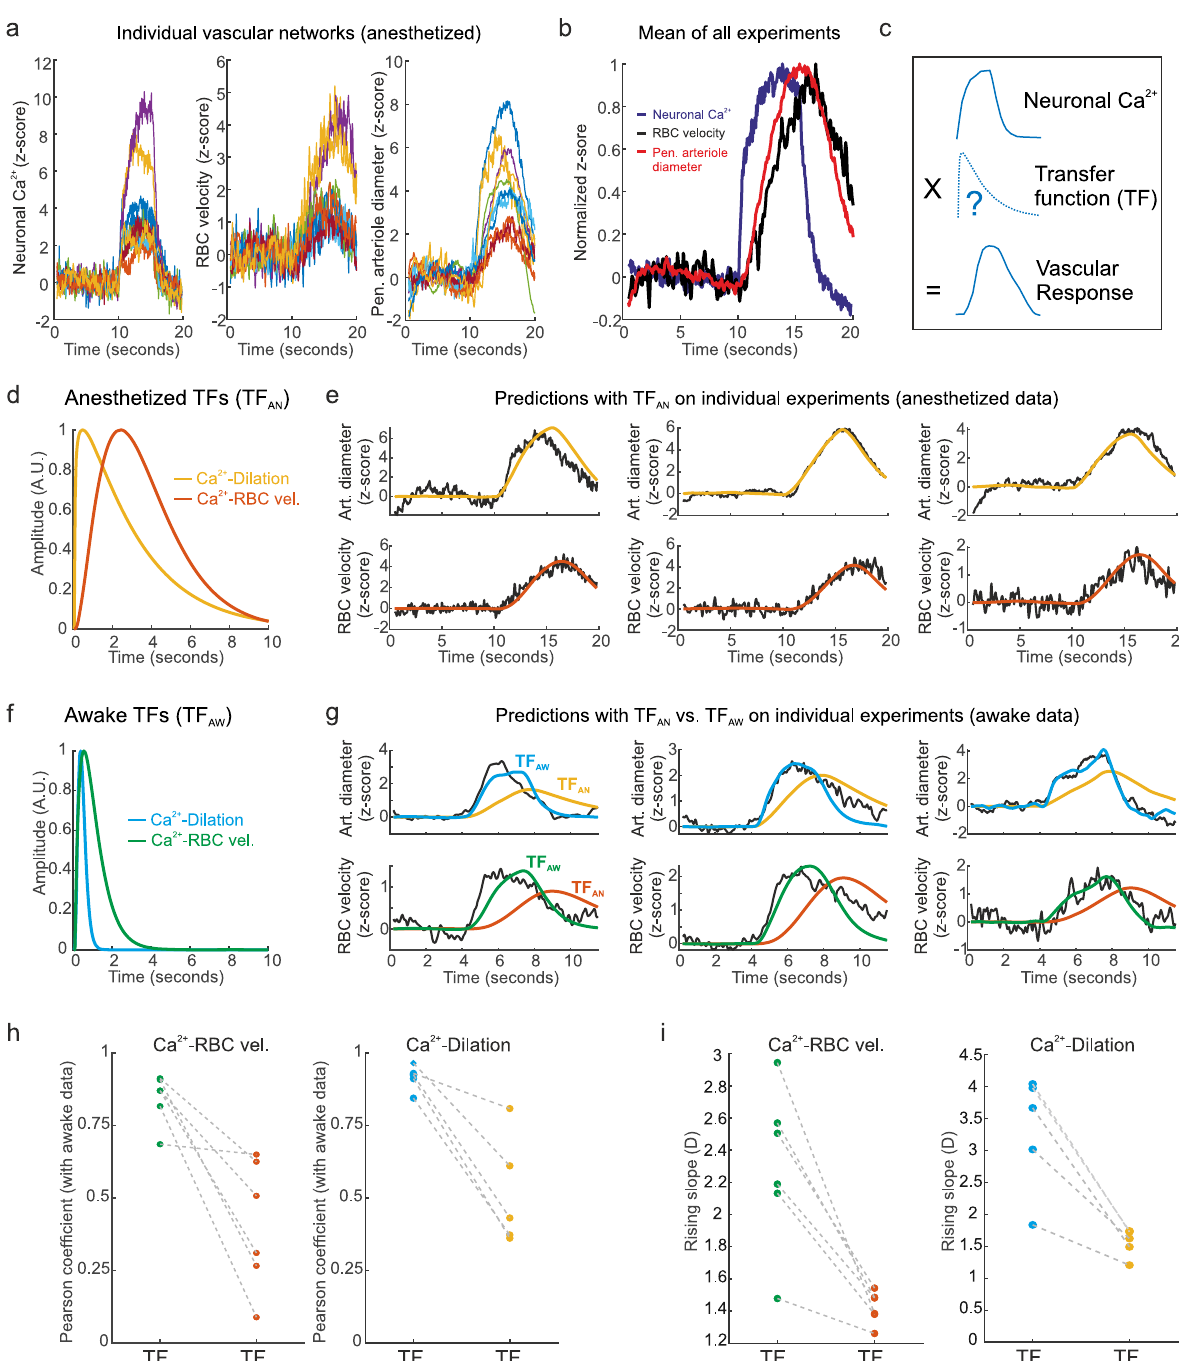
Fig. 4 Analysis of differential NVC dynamics in awake vs. anesthetized mice using TFs. a Overlaid dynamics of Neuronal Ca 2 + (GCaMP6 signal), RBC velocity ( ≥ 4th order capillaries), and penetrating arteriole diameter from all anesthetized experiments (10 vascular networks, 6 mice). b Mean traces of normalized data shown in a . c Transfer functions (TFs) are convolved with the average neuronal Ca 2 + signal and optimized to predict the vascular response (RBC velocity or arteriole diameter). d TFs optimized to predict arteriole dilation (yellow) or RBC velocity (orange) dynamics computed with the mean anesthetized data. e TF predictions for arteriole diameter (top) and RBC velocity (bottom) from the experimental data from 3 different anesthetized experiments (TF AN ), top and bottom are paired experiments. f TFs optimized to predict arteriole dilation (blue) or RBC velocity (green) dynamics computed with the mean awake data (TF AW ). g Comparison of (TF AW ) and (TF AN ) prediction for arteriole diameter (top) and RBC velocity (bottom) from the experimental data from 3 different awake experiments, top and bottom are paired experiments. h Correlation of (TF AW ) and (TF AN ) with awake experimental data for RBC velocity (left) and arteriole diameter (right). i Comparison of rising slope for TF predictions made with (TF AW ) and (TF AN ) on awake data for RBC velocity (left) and arteriole diameter (right). The slope is de fi ned as the D parameter of the 4-parameter sigmoidal fi t formula: A + B /(1 + exp( − ( − x − C) * D)). Data here are also represented in Figs. 1 –